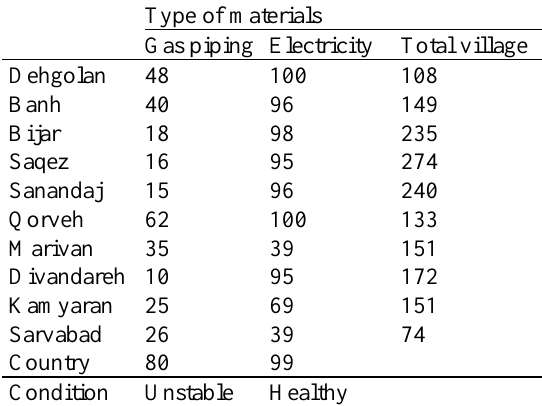
Table 6. Status of rural housing facilities in Kurdistan province and Iran (2013)